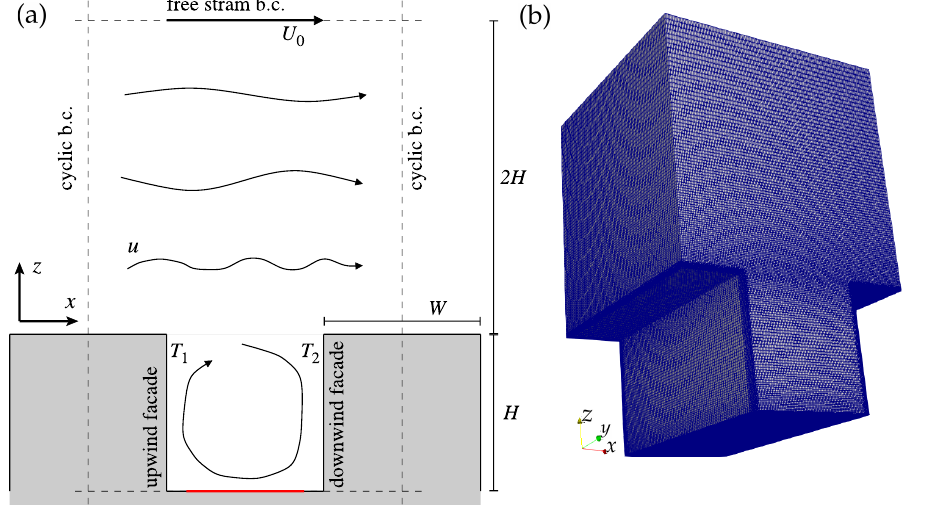
Figure 1. Sketch of the simplified urban canyon geometry and computational mesh used. ( a ) The geometry of the case study. The computational domain is bounded by dashed lines; the red line in the canyon delimits the pollutant release region. ( b ) Overview of the computational